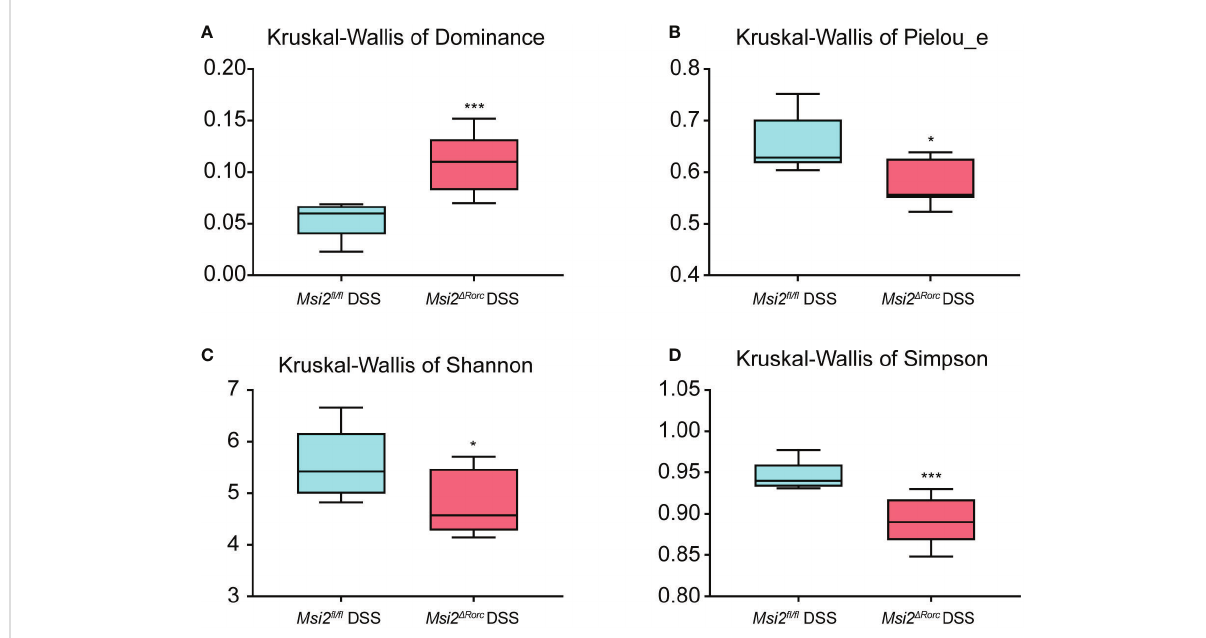
FIGURE 5 Alpha diversity analysis of the intestinal microbiota between the two groups. Hypothesis tests of the alpha diversity index using the Kruskal − Wallis H test. Dominance, Pielou_e, Shannon, and Simpson (A – D) diversity indices between the Msi2 fl / fl DSS group and the Msi2 D Rorc DSS group con fi rmed that there were signi fi cant disparities in species diversity between these two groups (n=8). *p < 0.05, ***p < 0.001.